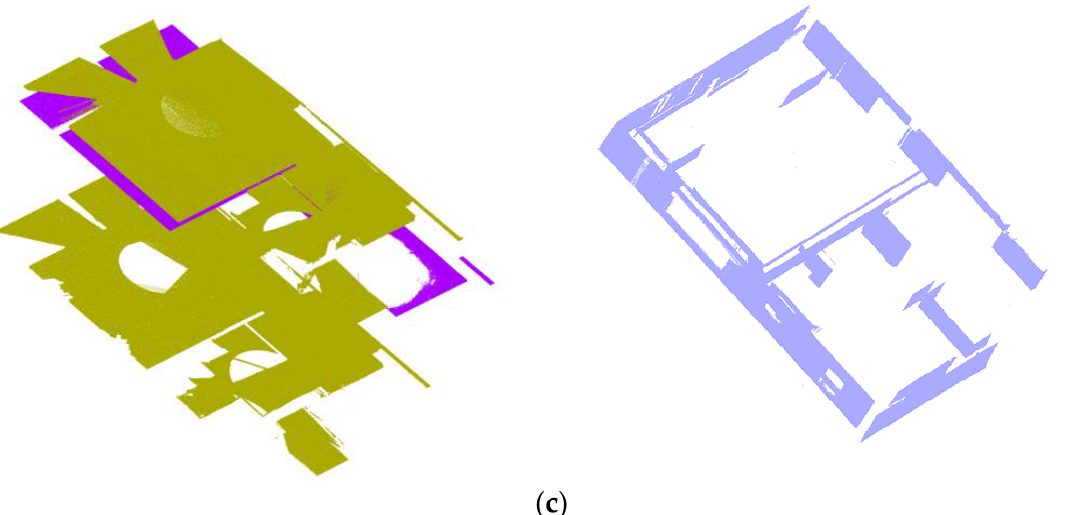
Figure 25. Results of segmentation of floors, ceilings, and walls: ( a ) proposed approach; ( b ) density- based clustering [36]; ( c ) DGCNN with the neighbor network [17].